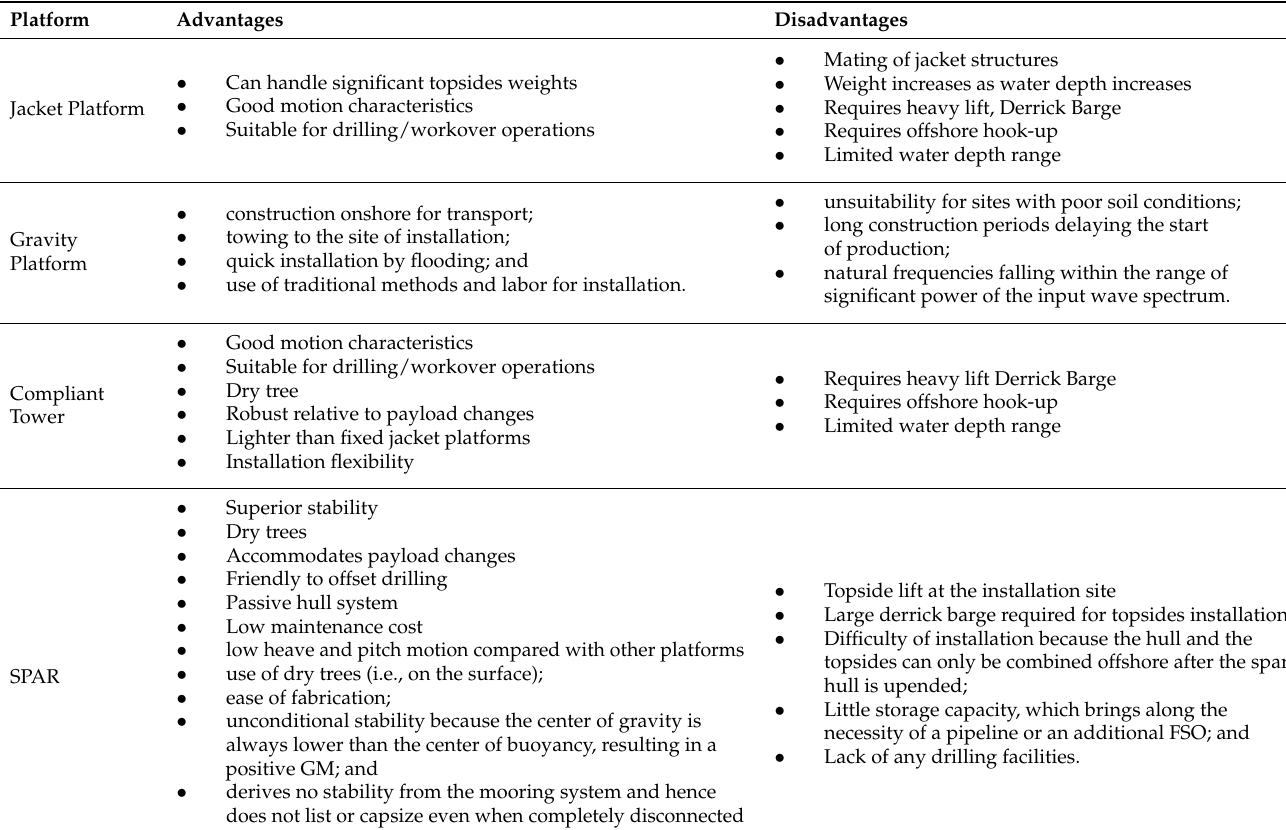
Table 13. Advantages and Disadvantages of offshore